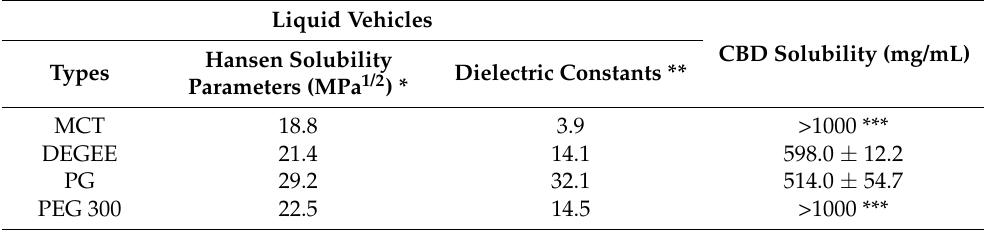
Table 1. Solubility of CBD in neat vehicles at 37 ± 0.5 ◦